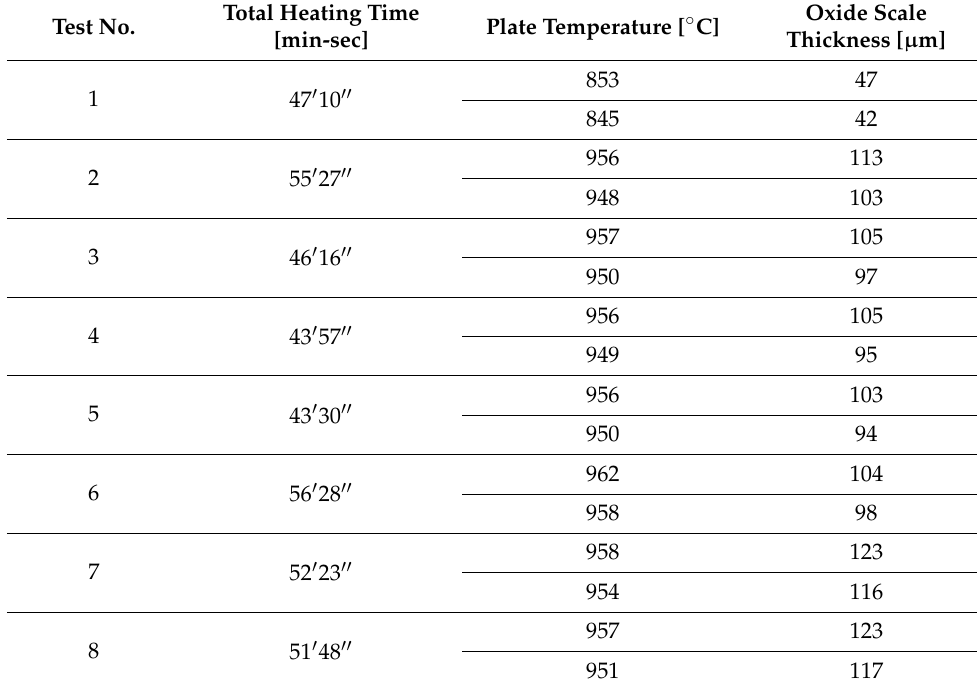
Table 2. Measured temperature and calculated scale thickness at the exit of the furnace on the top (above the line) and the bottom (below the line) surface of the plate